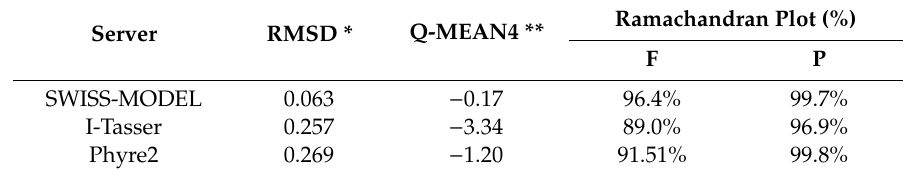
Table 1. Leishmania mexicana trypanothione reductase (LmTR) models constructed through homology modeling. Ramachandran Plot (%) Server RMSD * Q-MEAN4 ** F P SWISS-MODEL 0.063 − 0.17 96.4% 99.7% I-Tasser 0.257 − 3.34 89.0% 96.9% Phyre2 0.269 − 1.20 91.51%